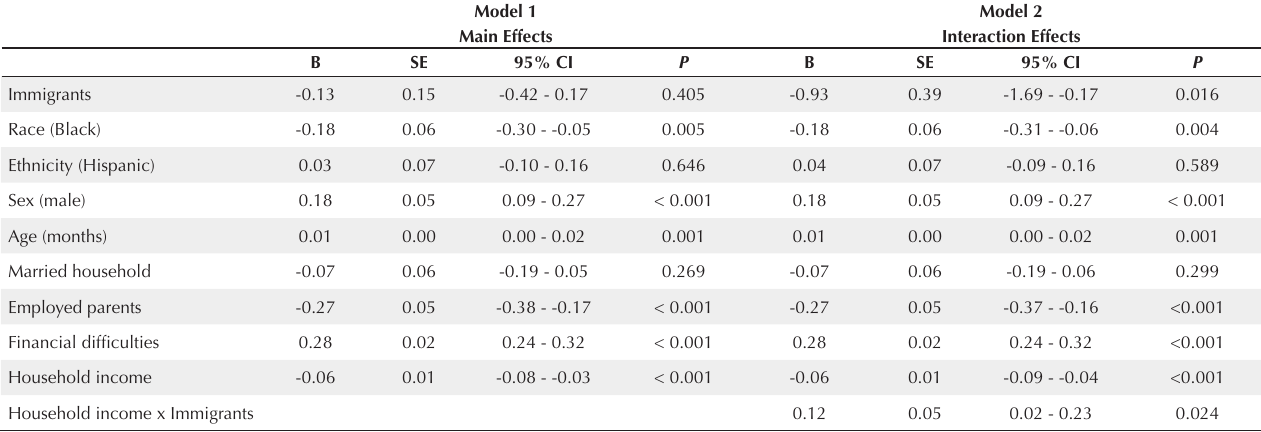
Table 2. Summary of Linear Regressions Overall (n = 6412)